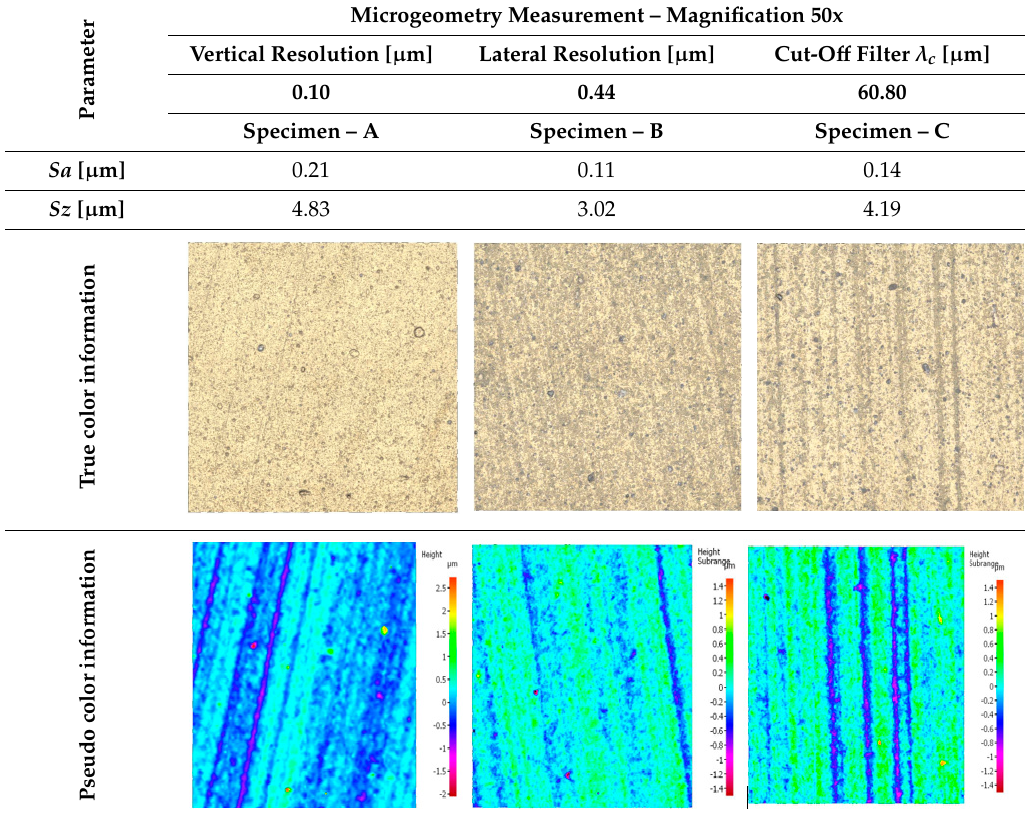
Table 4. Microgeometry measurement.